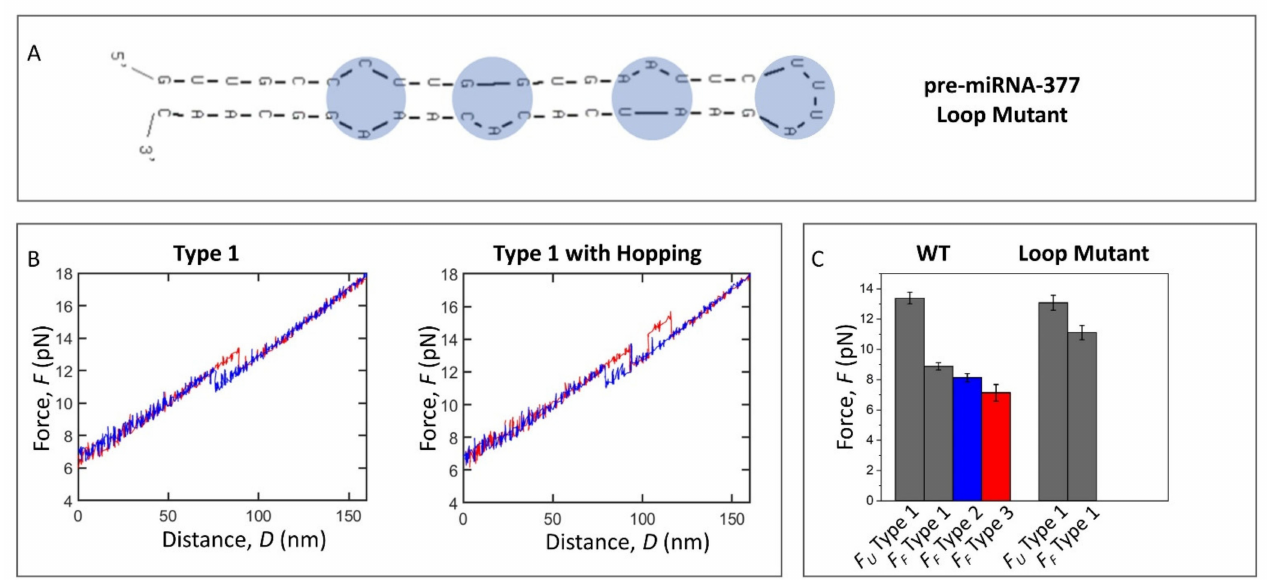
Figure 3. The pre-miRNA-377 loop mutant stability and dynamics. ( A ) The lowest energy secondary structure of the loop mutant predicted in UNAFold. ( B ) Force–distance curves (FDCs) of the loop mutant in Na + /Mg 2+ buffer: type 1 (one single-step unfolding and folding event) and type 1 with hopping (several single-step unfolding and folding events). Representative FDCs are plotted; unfolding—red and folding—blue. Force distribution can be viewed in Figure S4A. ( C ) Unfolding ( F U ) and folding ( F F ) forces in Na + /Mg 2+ buffer for the WT pre-miRNA-377 and the loop mutant; type 1—gray, type 2—blue, and type